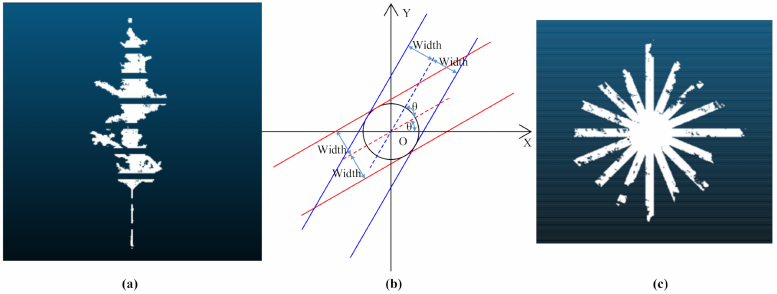
Figure 4. Schematic diagram of two kinds of slicing. ( a ) Horizontal slicing; ( b ) calculation of vertical slicing; ( c ) vertical